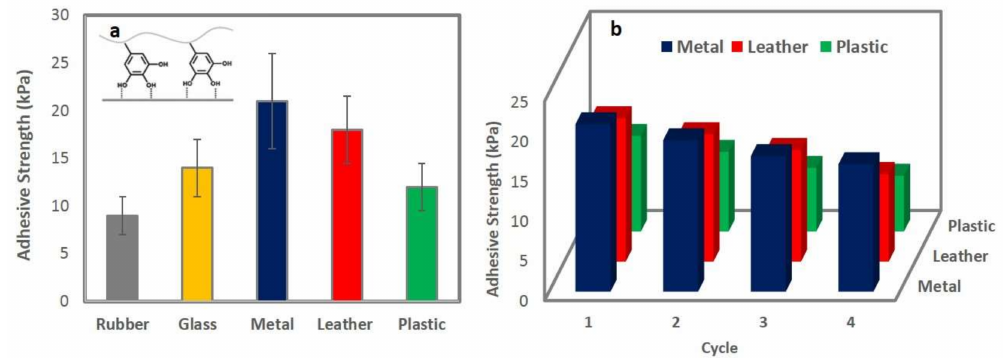
Figure 5. ( a ) Self-adhesive strength of the 1 wt.% TA-ChNF-reinforced hydrogel on di ff erent substrates measured by a tensile test; ( b ) cyclic self-adhesive tests on di ff erent